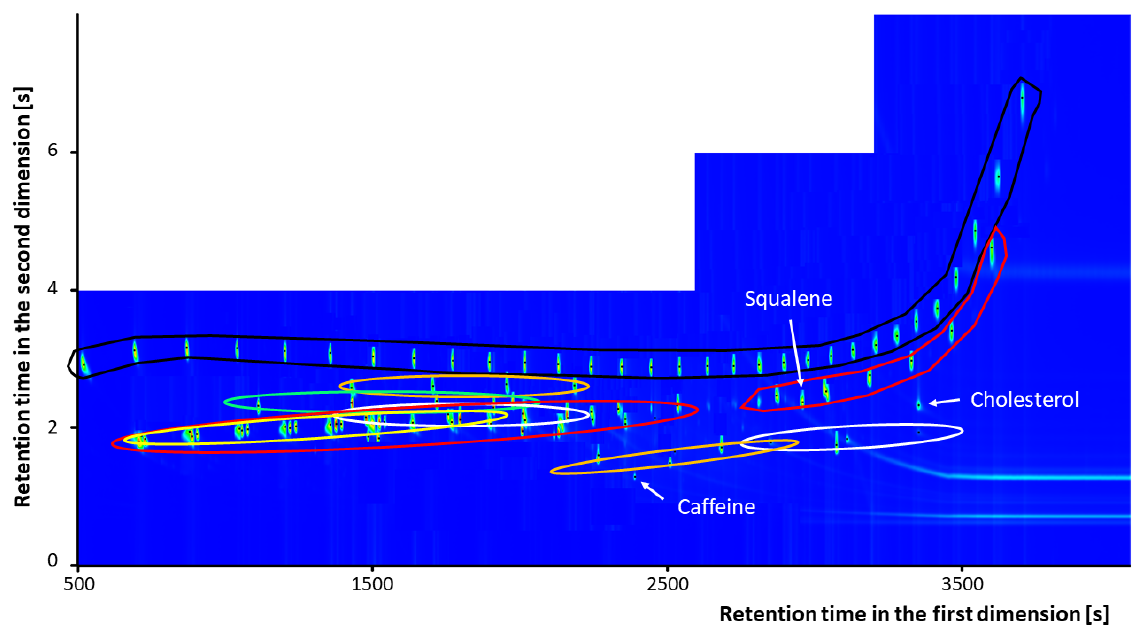
Figure 6. The TIC 2D chromatogram of the model mixture (composition see Table 1) measured under the conditions described in Section 2.4 on Rxi-17Sil MS (2 + 30 m) and TG-5HT (1 m) columns. The marked classification zones are the following: black ( n -alkanes), lower dark yellow (amines), upper dark yellow (amides), green (chloroalkanes), left white (alcohols), right white (ethers), yellow (aldehydes and ketones), left red (acids and esters), right red (esters of higher fatty acids), and unlabeled (others).